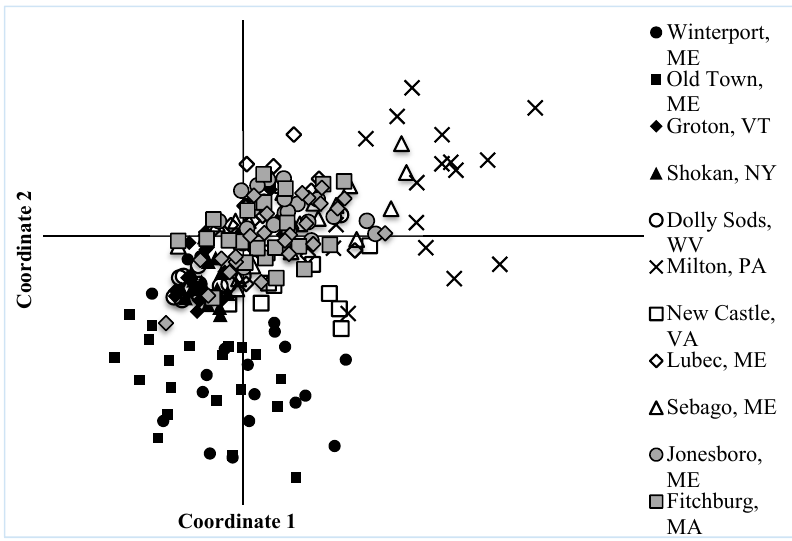
Figure 4. Principal coordinates (PCoA) analysis of genetic composition of non-managed lowbush blueberry populations ( n = 11).